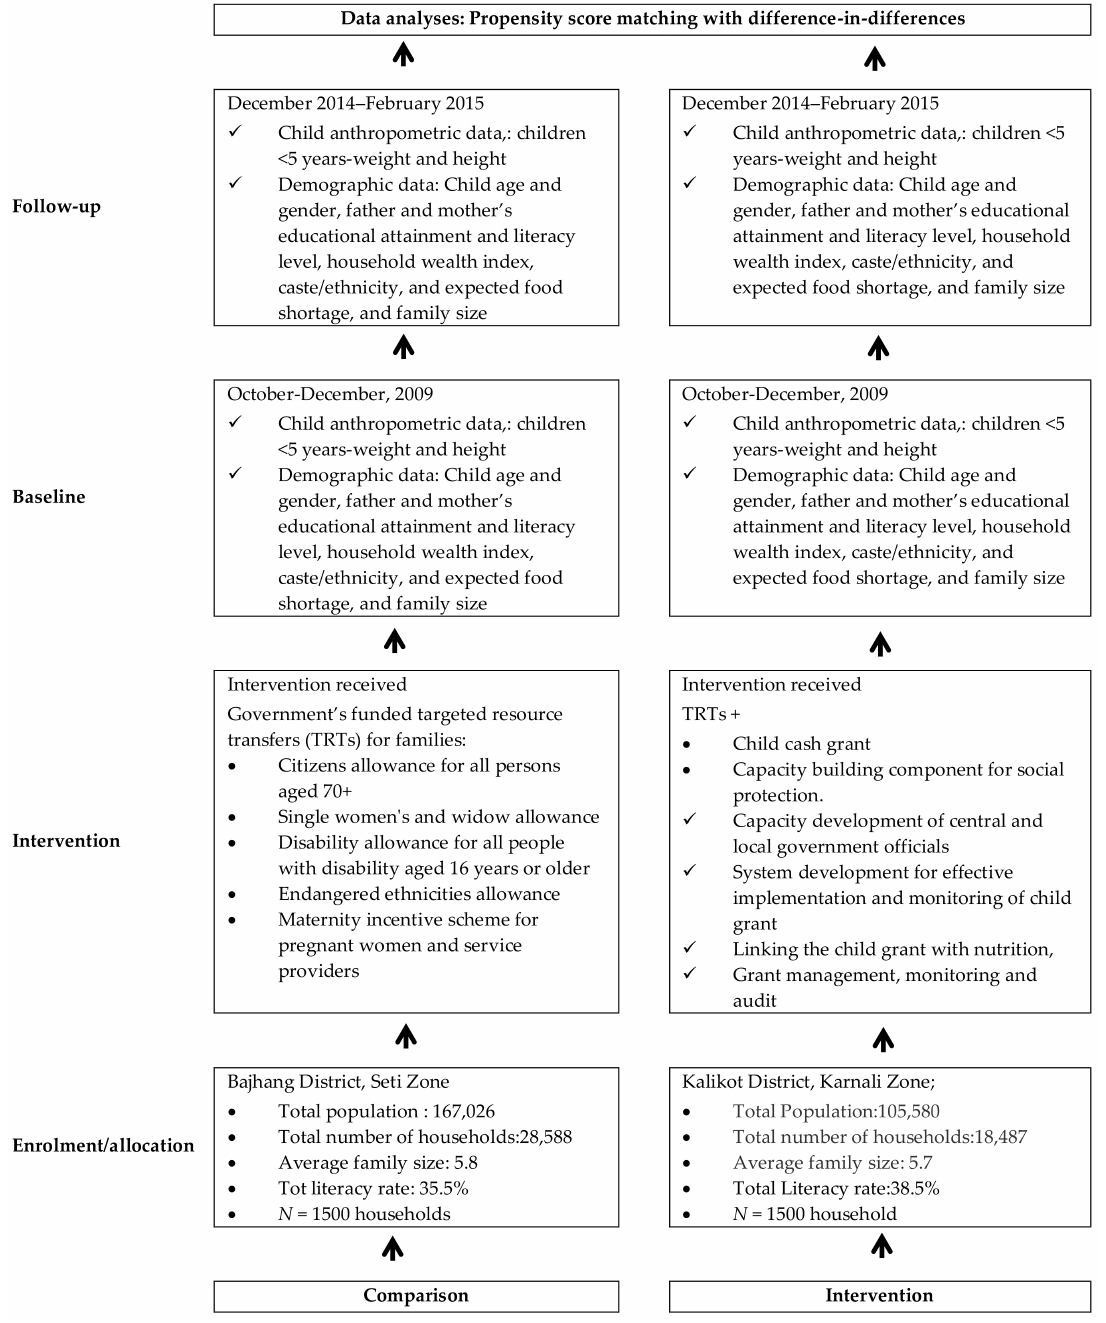
Figure 1. Flow diagram detailing the intervention implementation plan and data collection